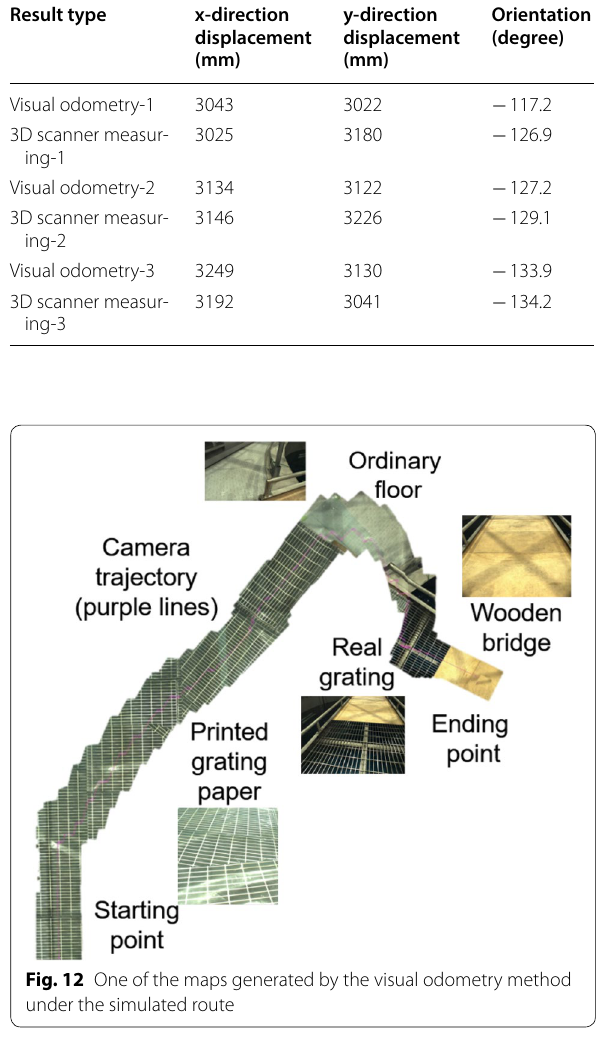
Table 3 Comparison results of visual odometry and 3D scanner under simulated routes Result type